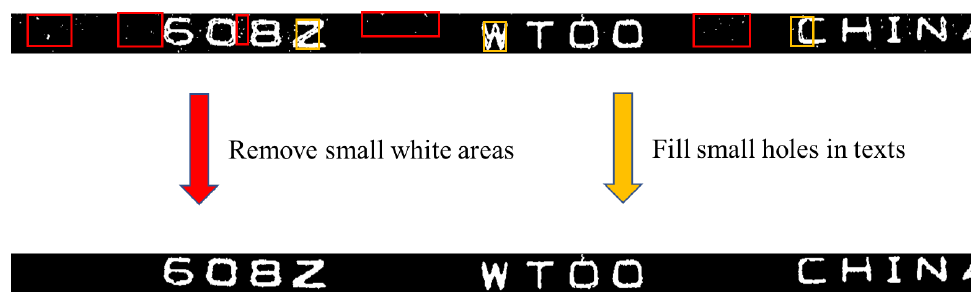
Figure 12. The removal process of small connected domains and holes in a dust